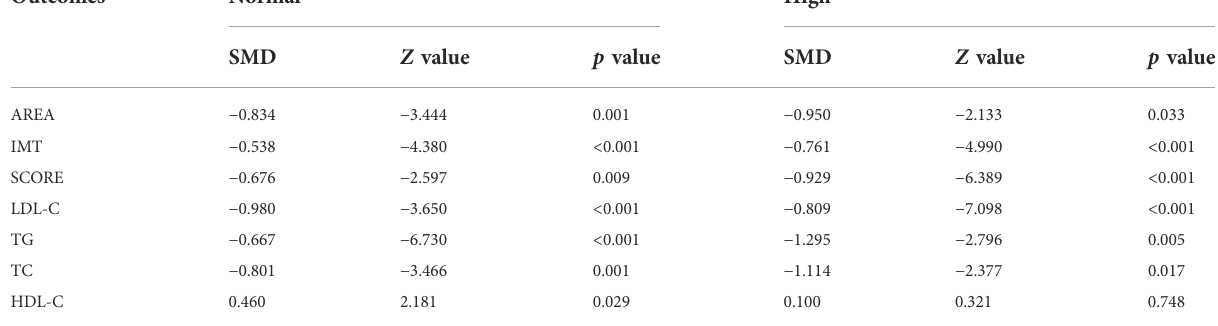
TABLE 6 Subgroup analysis strati fi ed by dosage of